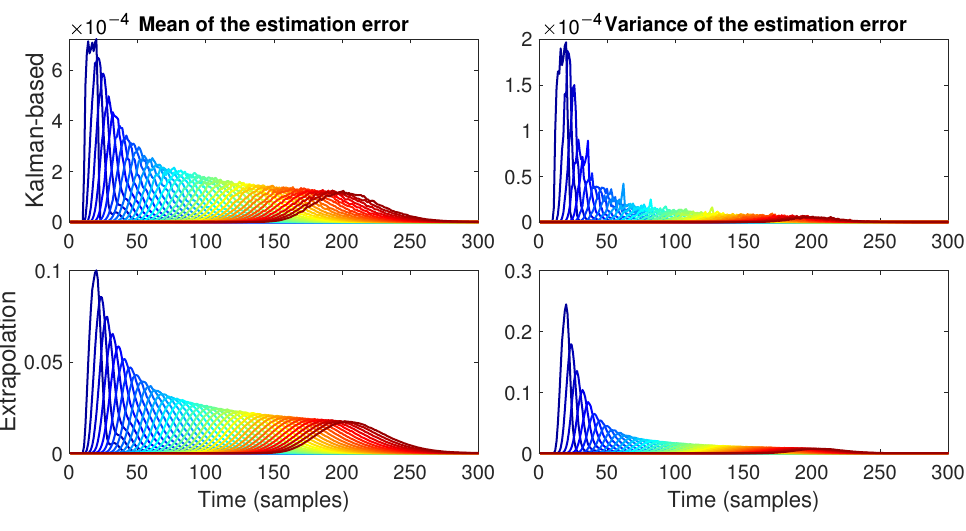
( k ) and variance σ 2 ( k ) of the estimation error for p = 0.95. In this case, Figure 14. Mean µ ε ε i i the Kalman-based strategy has a peak mean value of 6 × 10 − 4 and a variance of 2 × 10 − 4 , whereas the extrapolation strategy has peak values of 0.1 and 0.2 for its mean and variance,